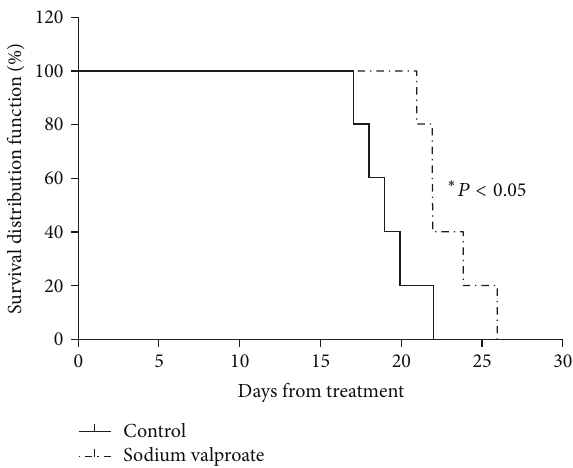
Figure 9: Percentage survival of animals in control and sodium valproate-treated groups. Animals in both sodium valproate-treated and control groups were monitored every day from the first day of treatment until death. By using the Kaplan-Meier method, survival times were determined. The mean percent survival of sodium valproate treated animals was significantly higher, 60% compared to the untreated control, which was 20% over 22